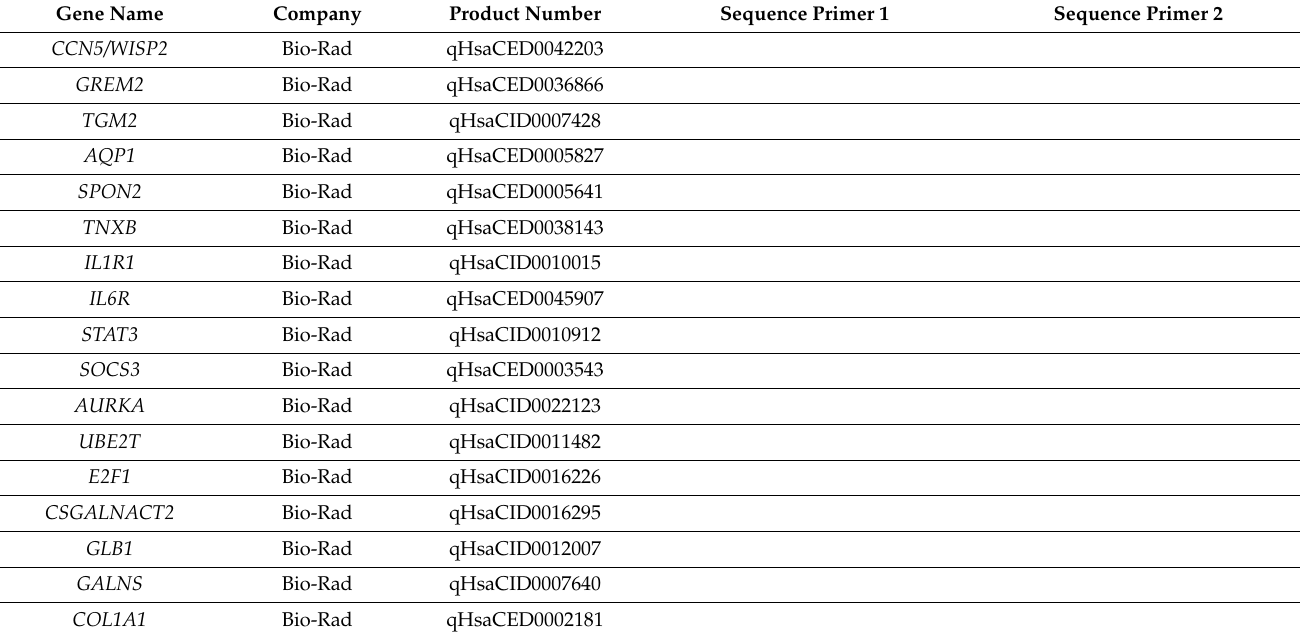
Table 1. Primers used for